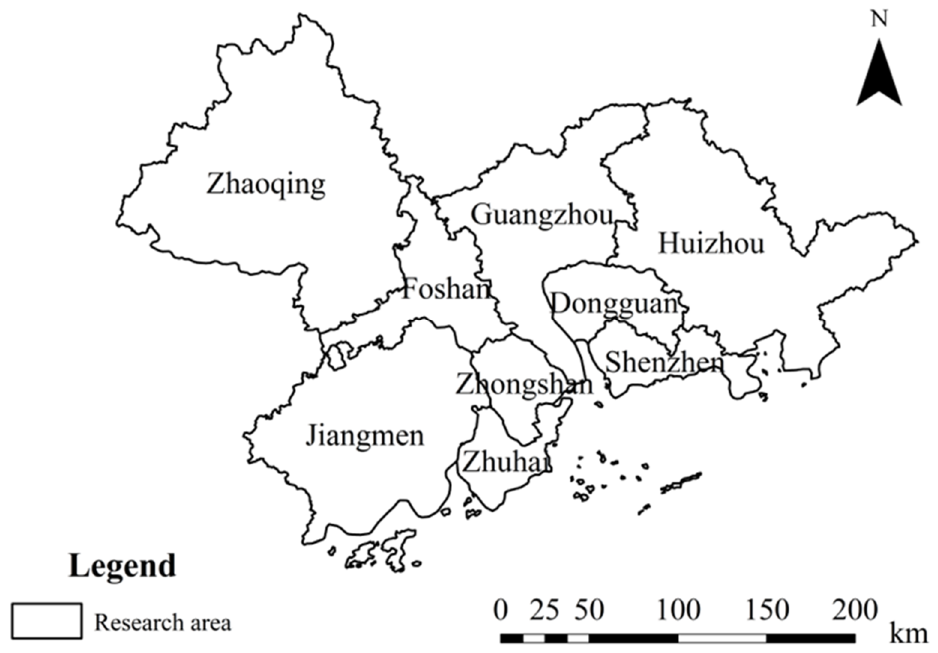
Figure 1. Overview of the study area in the GBA. We collected Baidu migration data for each city and obtained the data for 265 days from 14 September 2021 to 5 June 2022 (https://qianxi.baidu.com). The attributes of these data contain the daily flow-in and flow-out scale indexes of each city in the GBA. We obtained 481,770 Baidu migration data records, and then eliminated invalid records. Finally, we obtained a total of 38,160 Baidu migration data records for the study area. The data attributes and examples are listed in Table